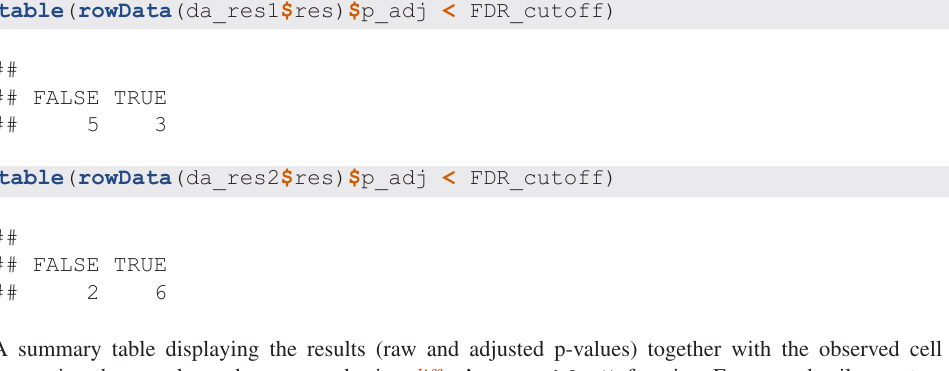
function. For more details, see topTable() ?topTable